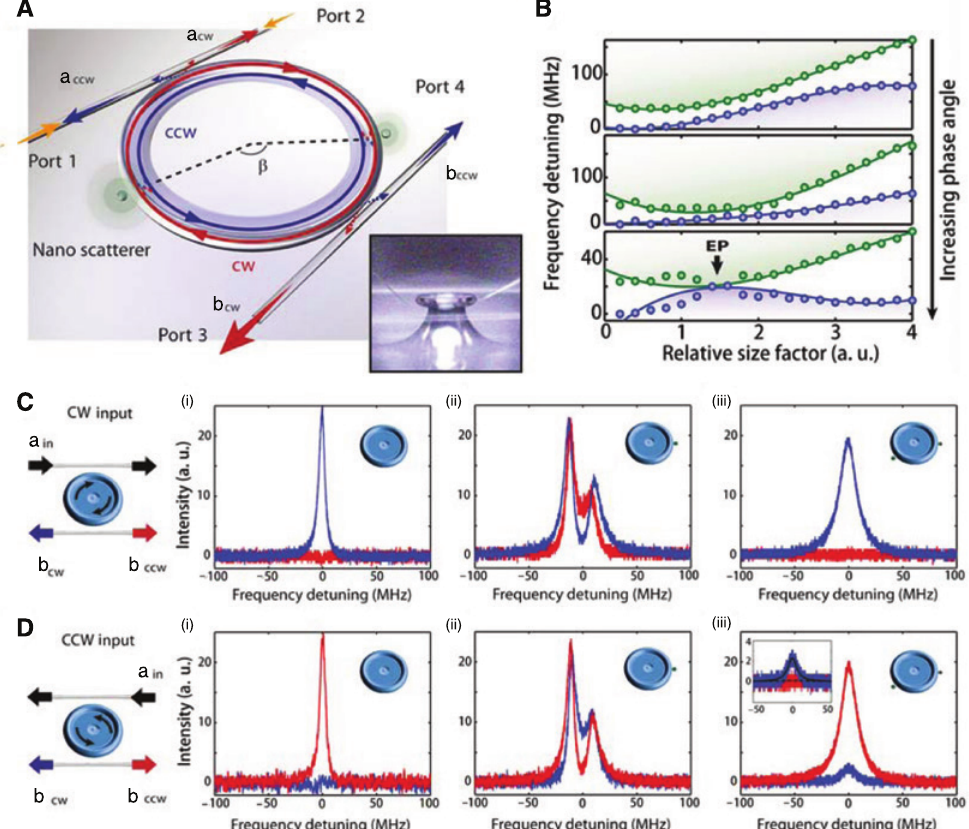
Figure 11: Experimental observation of scatterer-induced asymmetric backscattering in a WGM resonator side-coupled to two waveguides. (A) Illustration of a WGM resonator side-coupled to two waveguides, with the two scatterers enabling the dynamical tuning of the modes. cw and ccw are the clockwise and counterclockwise rotating intracavity fields. a and b are the field amplitudes propagating in the cw(ccw) cw(ccw) waveguides. β is the relative phase angle between the scatterers. Inset shows the optical microscope image of the microtoroid resonator, the tapered fiber waveguides (horizontal lines), and the two silica nanotips denoting the scatterers (diagonal lines on the left and right sides of the resonator). (B) Varying the size and the relative phase angle of a second scatterer helps to dynamically change the frequency detuning (splitting) and the linewidths of the split modes revealing avoided crossings (top) and an EP (bottom). (C and D) When there is no scattering center in or on the resonator, light coupled into the resonator through the first waveguide in the cw (C-i) [or ccw (D-i)] direction couples out into the second waveguide in the cw (C-i) [or ccw (D-i)] direction: the resonant peak in the transmission and no signal in the reflection. (C-ii and D-ii) When a first scatterer is placed in the mode field, resonant peaks are observed in both the transmission and the reflection regardless of whether the light is input in the cw (C-ii) or ccw (D-ii) direction. (C-iii and D-iii) When a second scatterer is suitably placed in the mode field, for the cw input, there is no signal in the reflection output port (C-iii), whereas, for the ccw input, there is a reso- nant peak in the reflection, revealing asymmetric backscattering for the two input directions. Inset in D-iii compares the two backscattering peaks in C-iii and D-iii